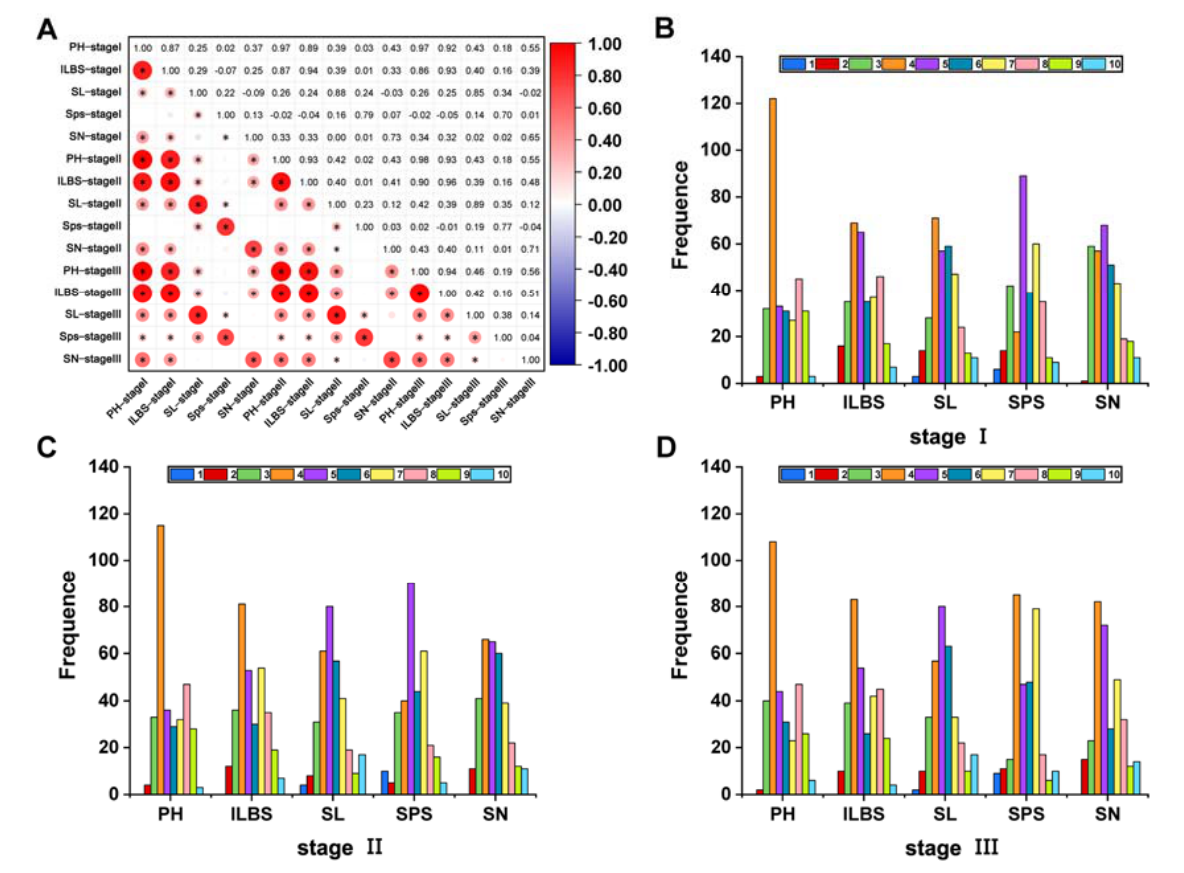
Figure 1. Correlation and genetic diversity analysis under different sowing dates. ( A ) Correlation analysis among wheat plant height and spike-related traits. ( B ) Grades distribution of each trait under the first sowing date. ( C ) Grades distribution of each trait under the second sowing date. ( D ) Grades distribution of each trait under the third sowing date. Different colors represent different grades from 1 to 10. Stage I, II, and III represent different sowing dates, respectively. YZ represents Yangzhou; YC represents Yancheng; PH represents plant height; ILBS represents internode length below spike; SL represents spike length; SPS represents spikelet per spike; SN represents spike number. * and ** indicate significant differences at the 0.05 and 0.01 levels, respectively.